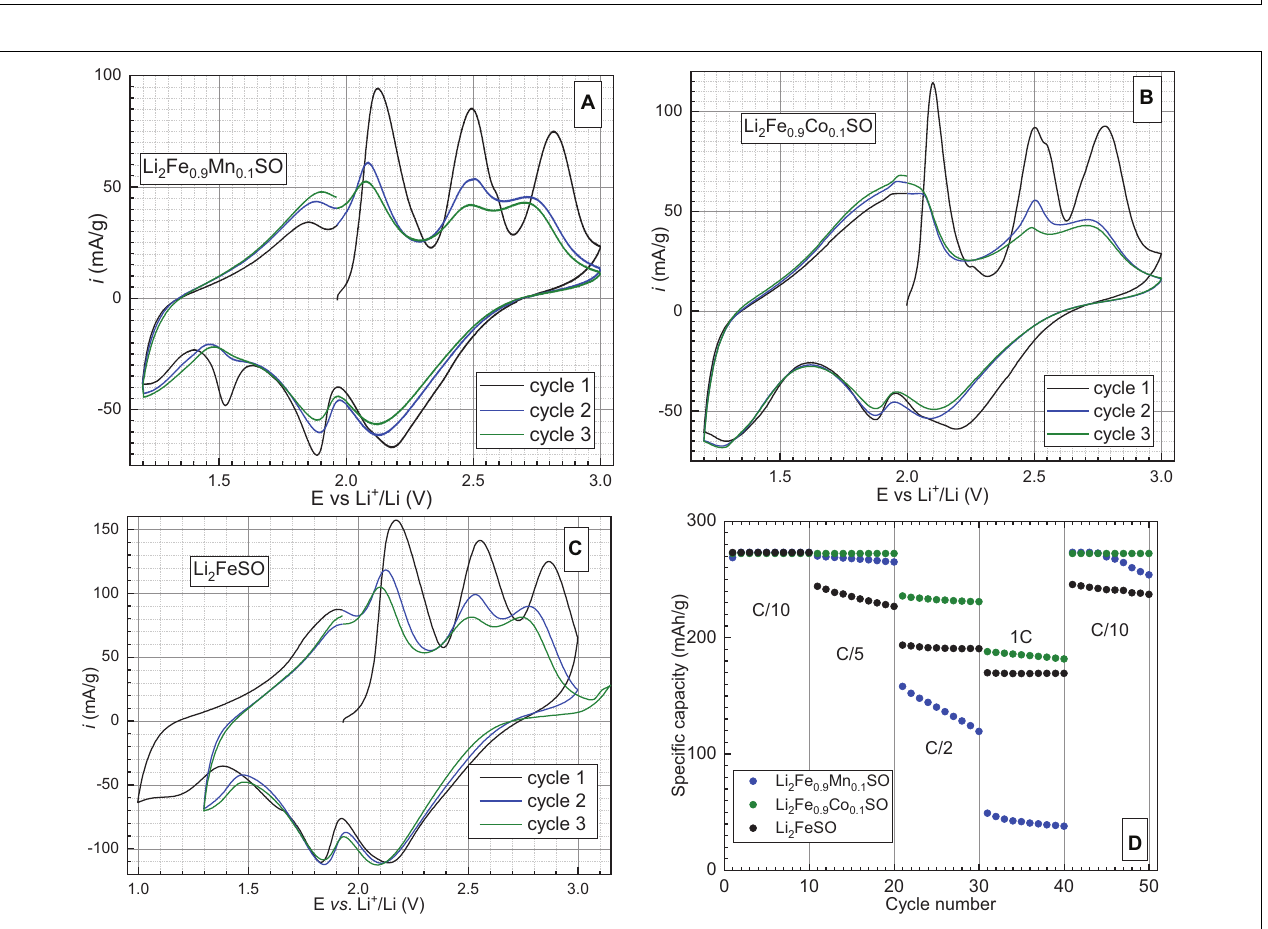
FIGURE 2 | Low scan rate cyclic voltammograms of (A) Li 2 Fe 0 . 9 Mn 0 . 1 SO. (B) Li 2 Fe 0 . 9 Co 0 . 1 SO and (C) Li 2 FeSO reference material recorded at 0.05 mV/s sweeping rate. (D) Specific discharge capacities of Li 2 Fe 0 . 9 M 0 . 1 SO (M–Co, Mn) and Li 2 FeSO materials at different current rates. Rate capability tests were performed two times for each material. The selected charge-discharge curves for Co-containing material which performed the best, are available in the Supplementary Material ( Supplementary Figure 3 ).